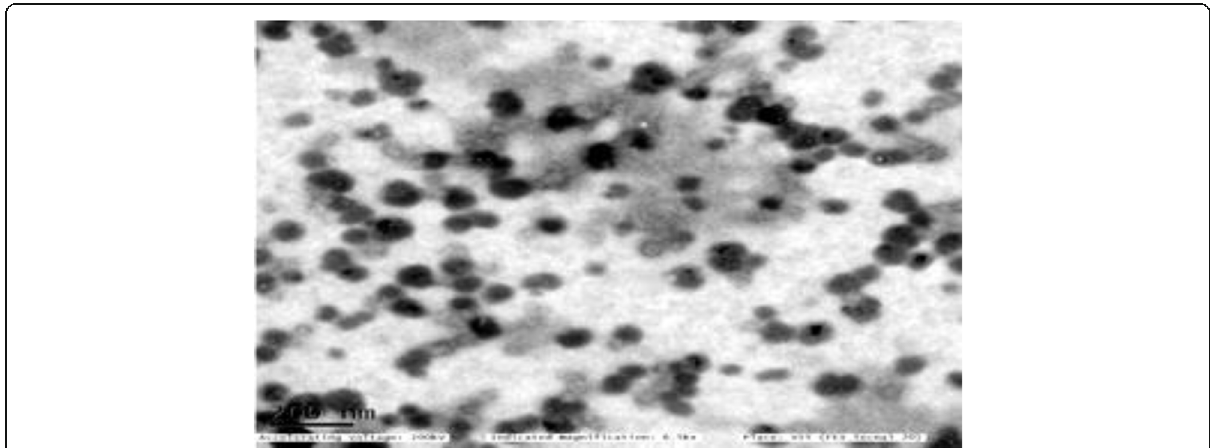
Fig. 4 TEM analysis of the biosynthesised selenium nanoparticles